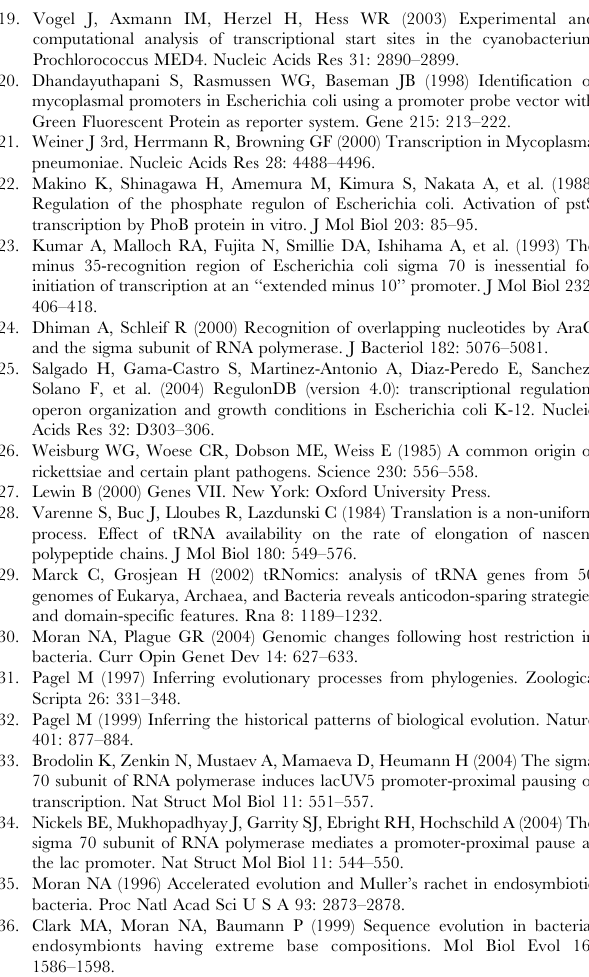
Table S3 Observed vs. expected counts of 2 10 motifs in nonfunctional regions. Total Sequence Length is the total number of base pairs analyzed for the corresponding type of region in each genome. NSD is the number of standard deviations that separate the observed motif count from the expected mean in that genome, NSD = (Obs-Mean)/SD.